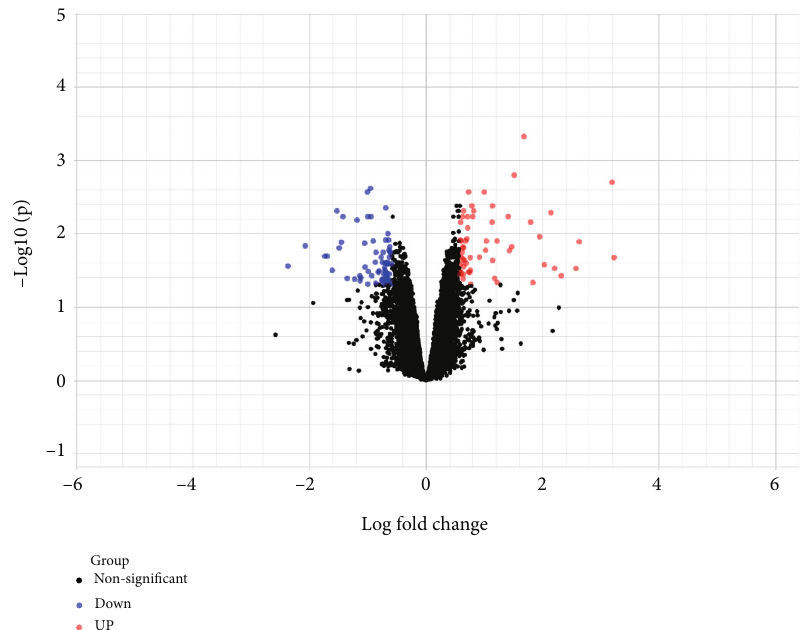
Figure 1: Volcano plot of di ff erentially expressed genes. Genes with a signi fi cant change of more than 1.5-fold were